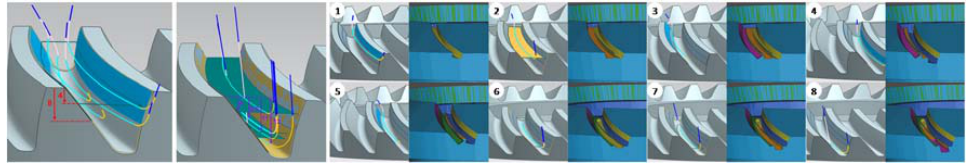
Figure 9. R ‐ IV roughing strategy. Figure 9. R-IV roughing strategy.